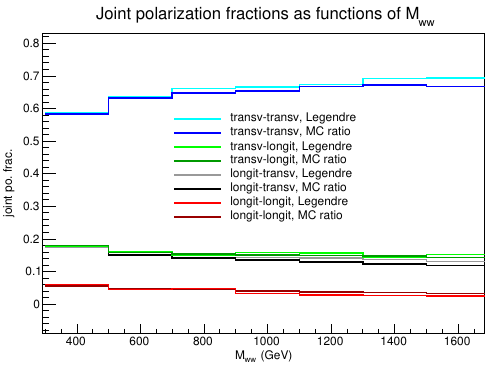
Figure 4. Double polarization fractions as functions of M WW . The right and left handed con- tributions are summed together in the transverse component W T = W R + W L . The polarization components obtained by expanding, in each bin, the full angular distribution on Legendre poly- nomials are shown in lighter colors. The darker histograms are obtained integrating the polarized amplitudes